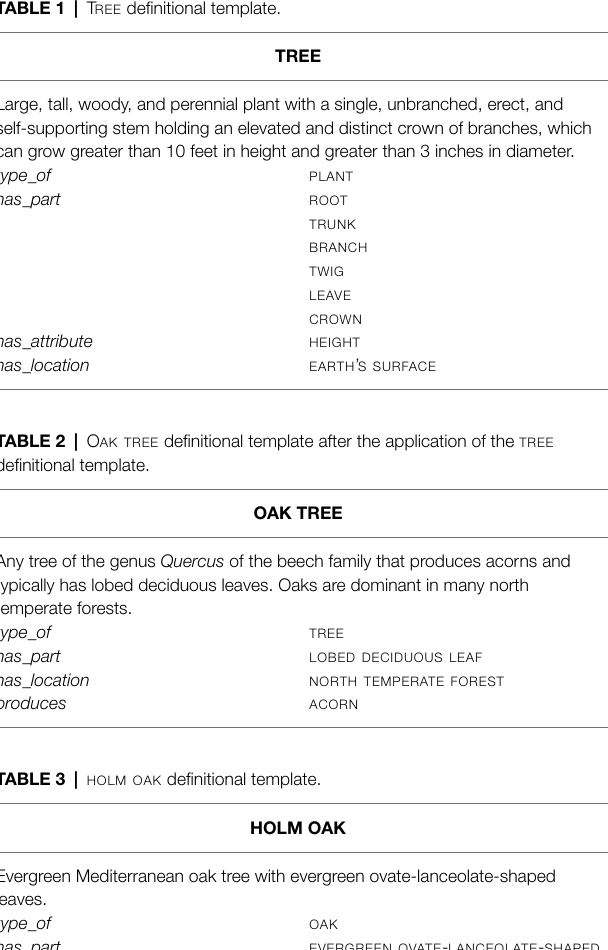
TABLE 1 | T ree definitional template.